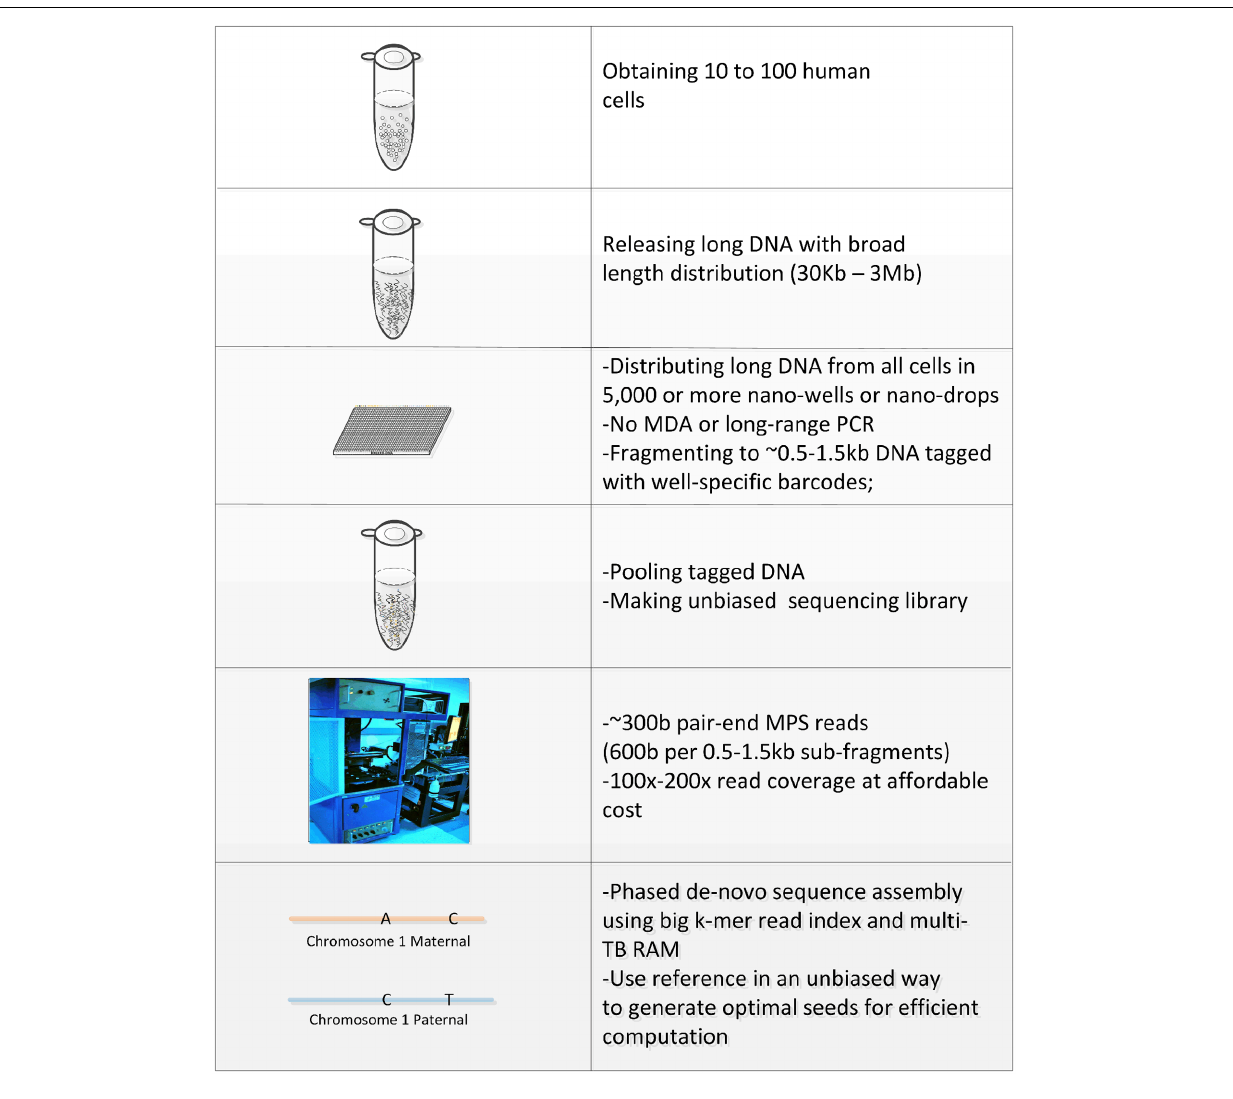
FIGURE 2 | Integrated “perfect genome” solution. Our preferred end-to-end proposal for achieving the perfect genome is summarized in this table. The “perfect genome” starts with an input of 10–100 unfixed cells. Cells are lysed and long DNA fragments with a broad length distribution are released and divided into 5,000 or more compartments. Subfragments 500–1,500 bp in length are generated, without long DNA amplification, and labeled with a barcode specific to each compartment (co-barcoded). All